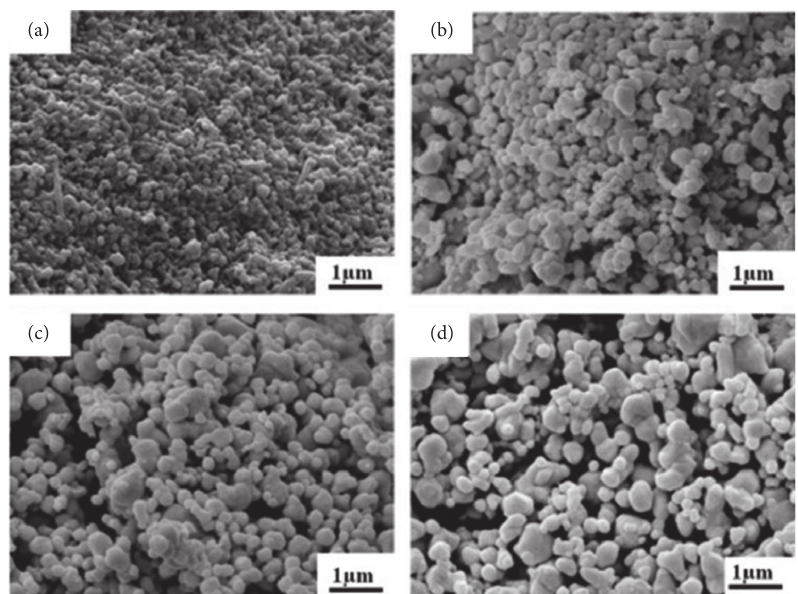
Figure 8: Scanning electron microscope (SEM) images of Ag